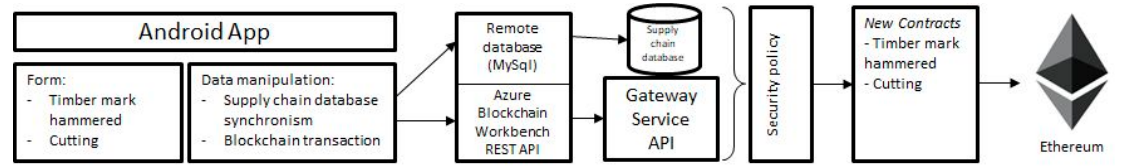
Figure 5. Interconnection diagram between the app developed (SmartTree, described below) and the blockchain.